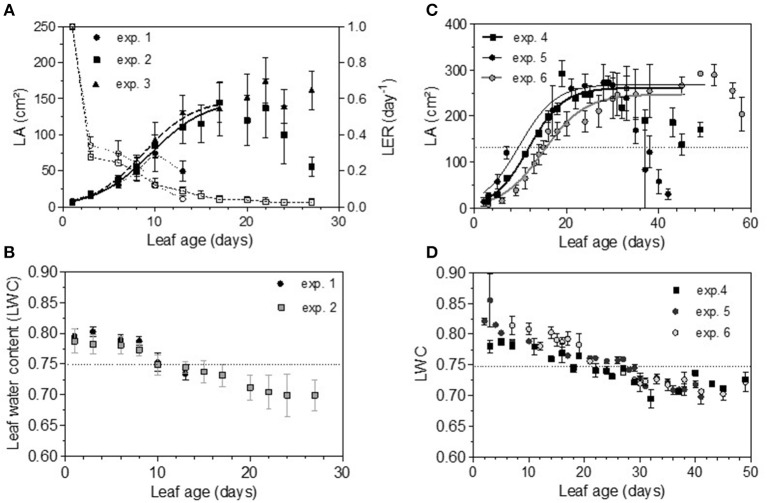
Evolution of leaf area (LA), leaf extension rate (LER) (dashed lines) and leaf water content (LWC) for Cabernet Sauvignon (A,B) and for Merlot (C,D). Bars indicate standard deviations.